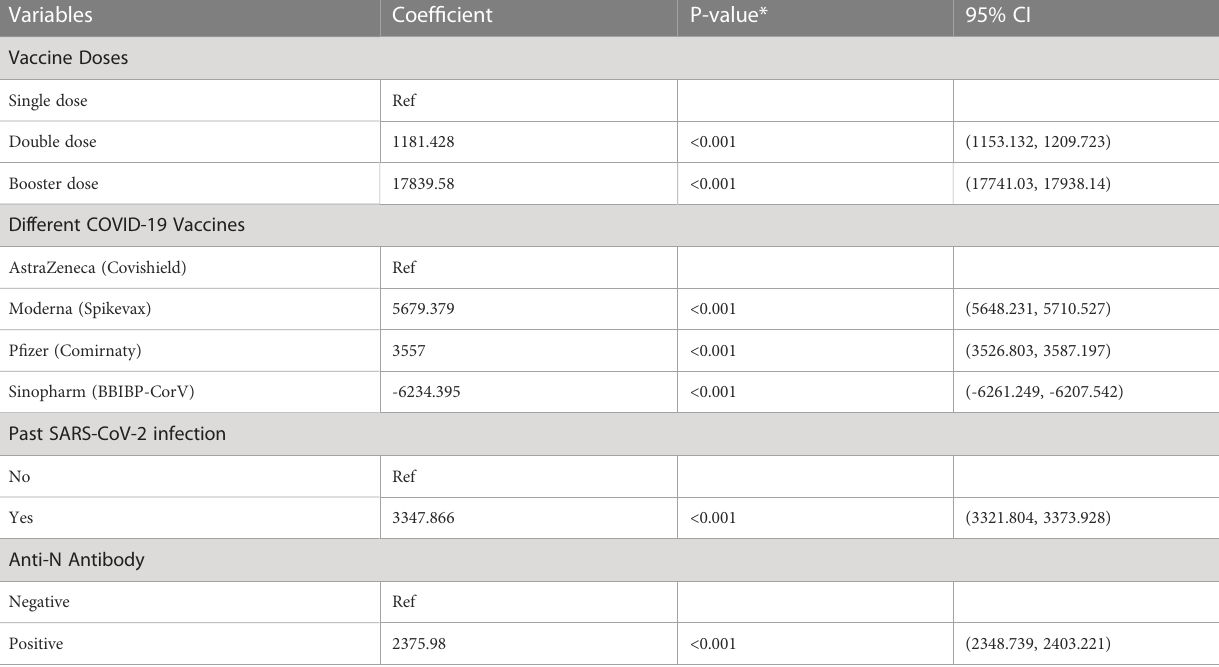
TABLE 3 Multivariate analysis for Anti-S antibody response to COVID-19 vaccines among the migrant workers, Bangladesh, 2021-22. Variables